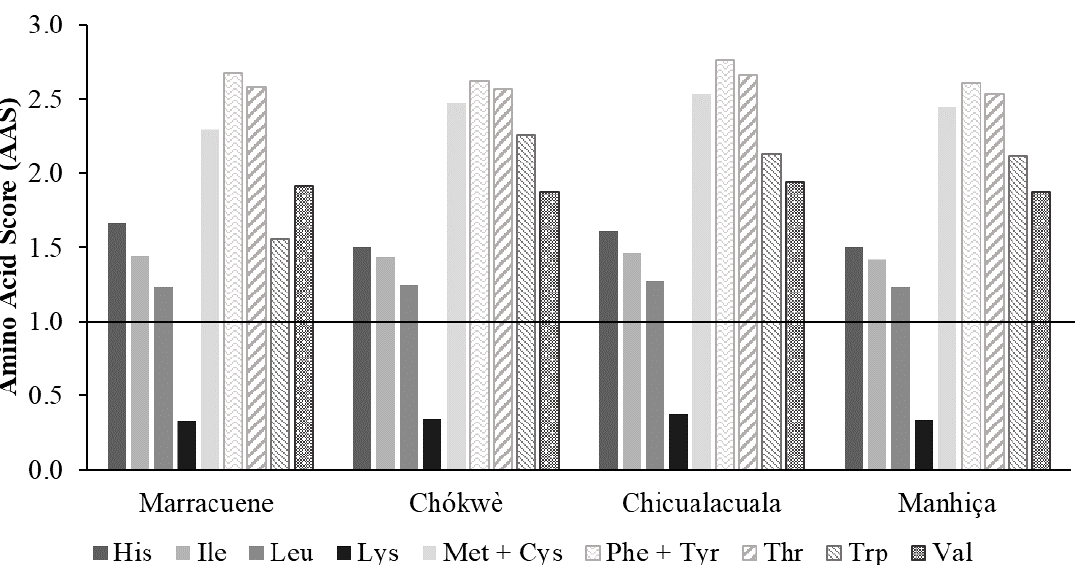
Figure 2. Essential amino acid scores (EAAS) of S. madagascariensis fruit flour ( nfuma ) from 4 districts of Mozambique. Adult maintenance patterns are expressed as mg AA/g protein: His. 15; Ile. 30; Leu. 59; Lys. 45; Met + Cys. 27; Phe + Tyr. 38; Thr. 23; Trp. 6.6; Val. 39, according with WHO/FAO/UNU [20].